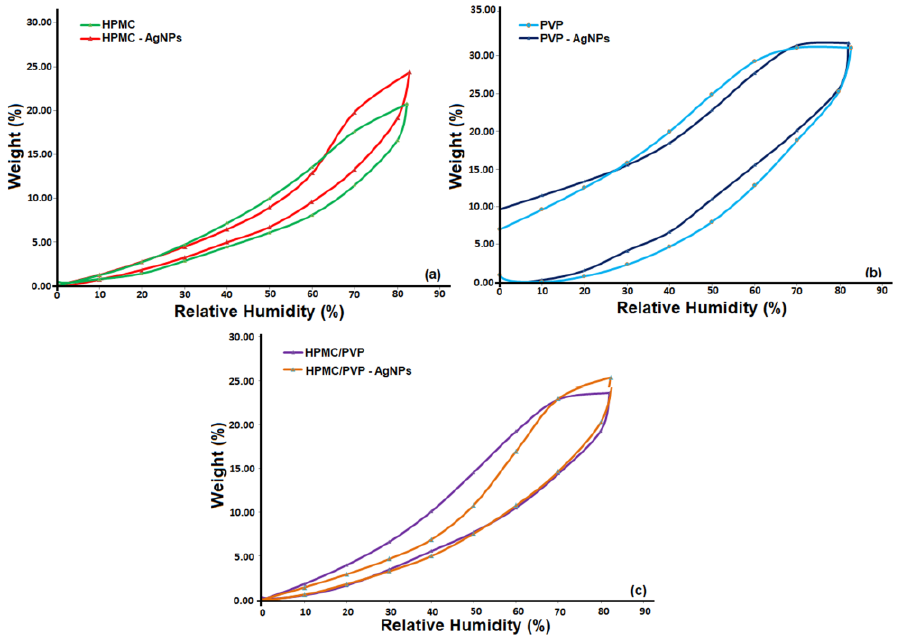
Figure 11. Sorption – desorption isotherms for studied materials: ( a ) HPMC and HPMC-AgNPs, ( b ) Figure 11. Sorption–desorption isotherms for studied materials: ( a ) HPMC and HPMC-AgNPs,